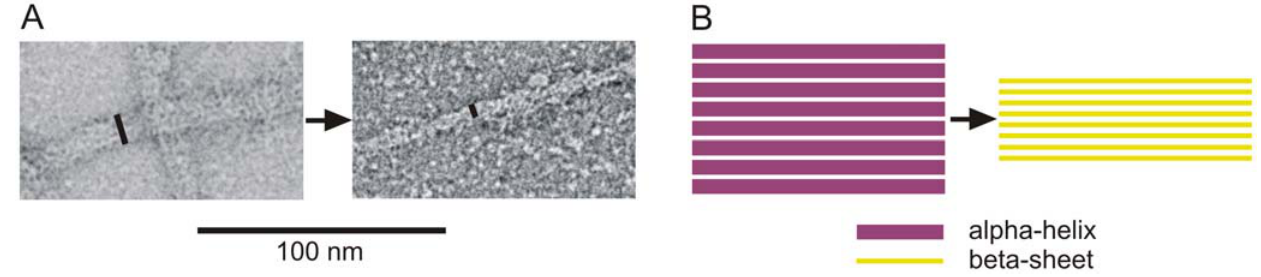
Figure 10. Experimental evidencefor interdimer sliding and subsequent filamentthinning. Panel A: Electronmicroscopy picture ofa mutant IF desmin DesA360P filament before and after shearing (adapted from reference [43]). Significant thinning of the filament diameter of < 55% seen in these experimental images suggests that a - b transitions and interfilament sliding occur, in agreement with simulation results (the diameter changes from < 12 nm to < 5.5 nm). Panel B: Schematic of the deformation process, illustrating the thinning of the filament due to formation of beta-sheets.